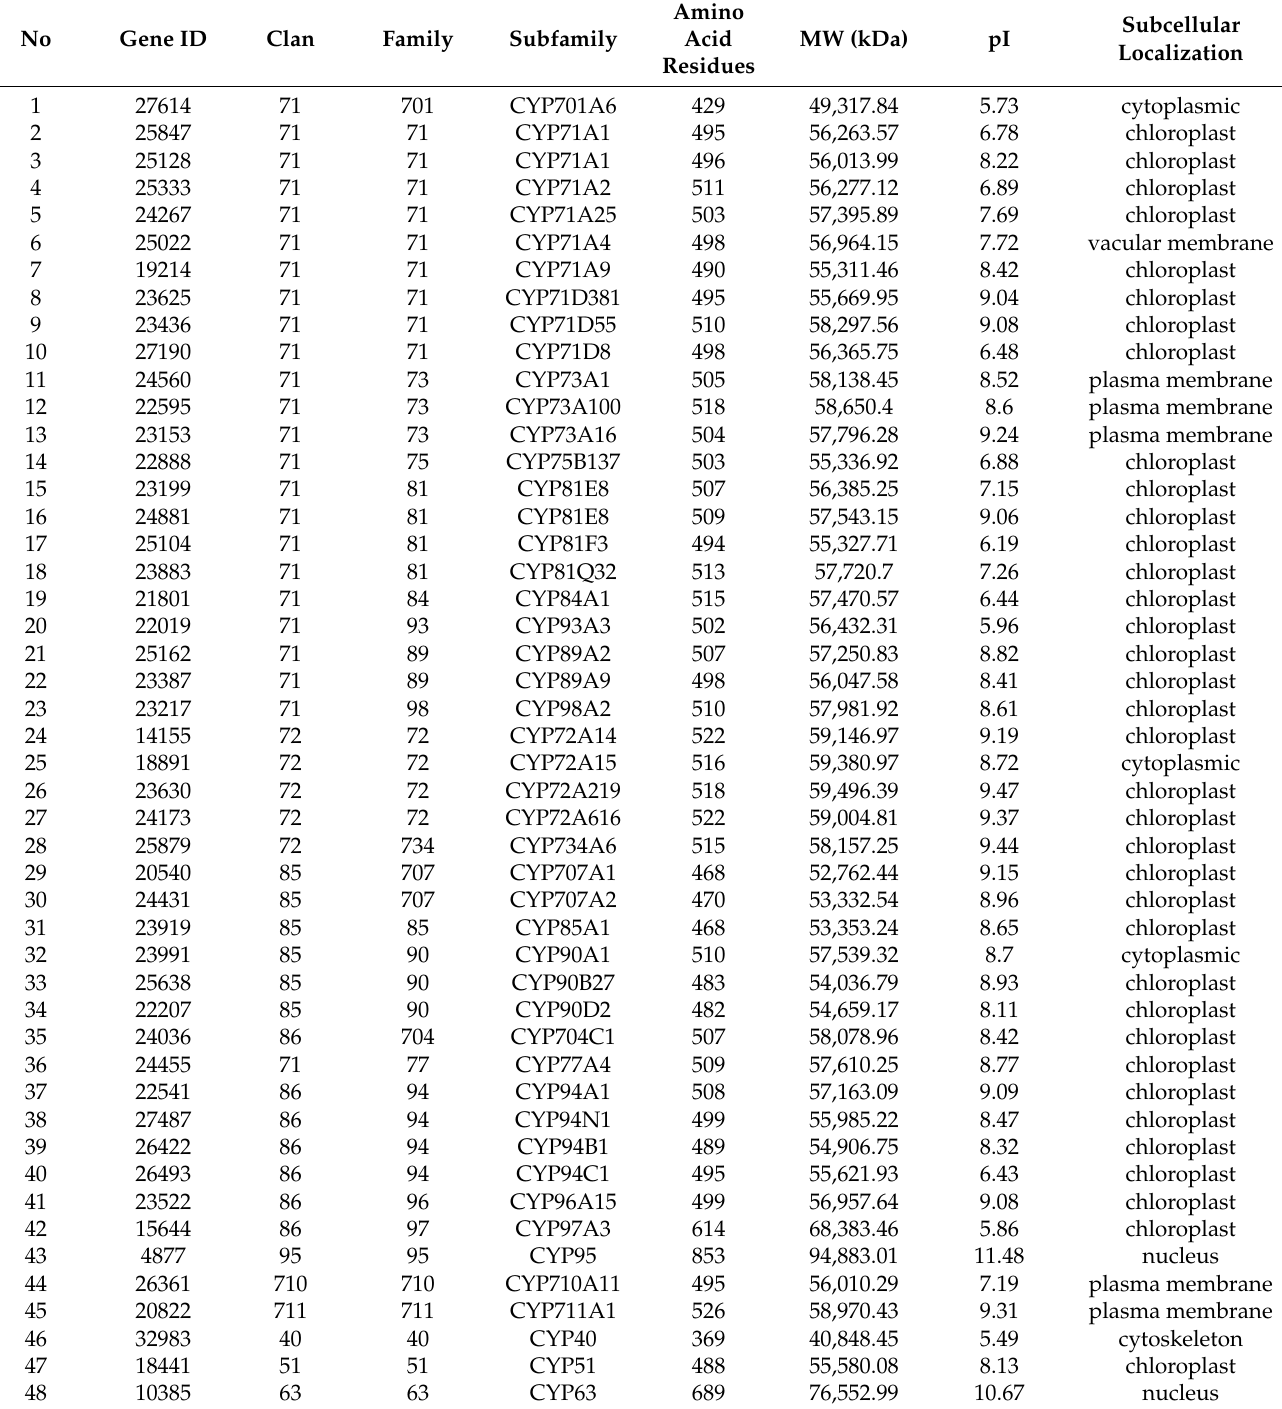
Table 1. List of 48 CYP450s of F. cirrhosa identified in this